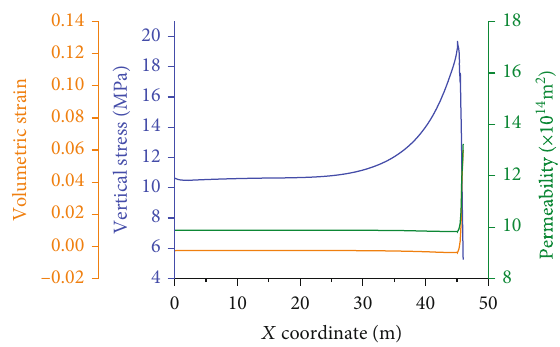
Figure 3: Distribution law of vertical stress, volumetric strain, and permeability in coal seam centerline.